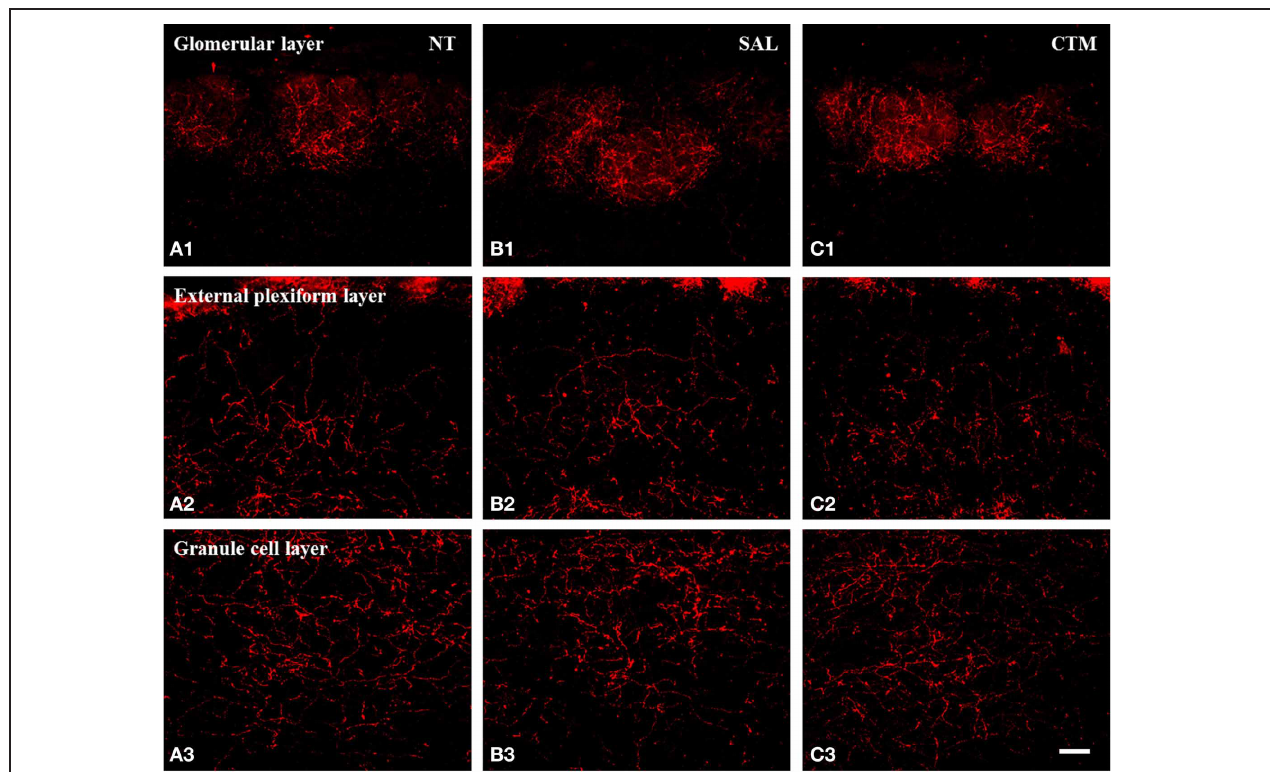
FIGURE 4 | Representative photomicrographs illustrating the distribution pattern of SERT-ir fibers in the OB of female rats. (A1–C1) The glomerular layer. (A2–C2) The external plexiform layer. (A3–C3) The granule cell layer. Note that SERT-ir fiber density remained